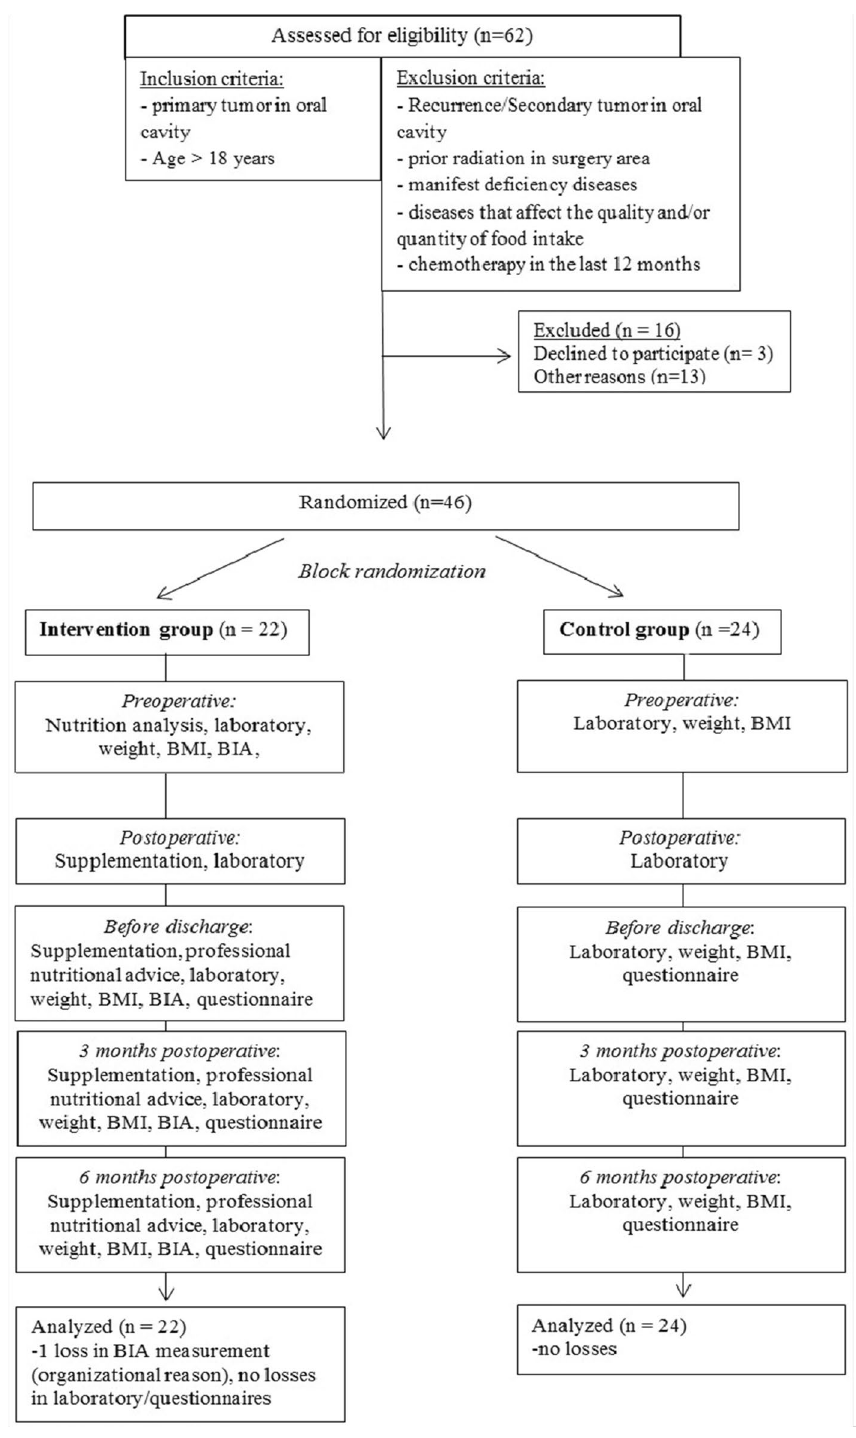
Figure 1. Summary of patient flow